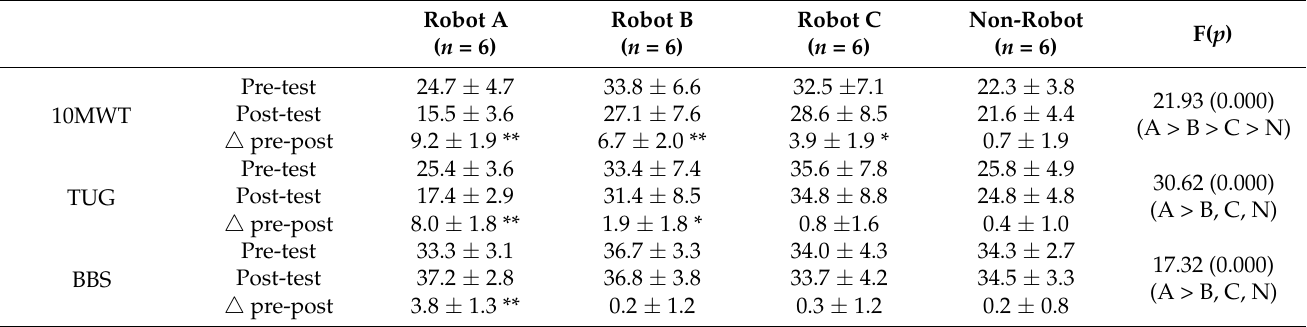
Table 2. Outcome variables before and after the interventions among the groups ( N =